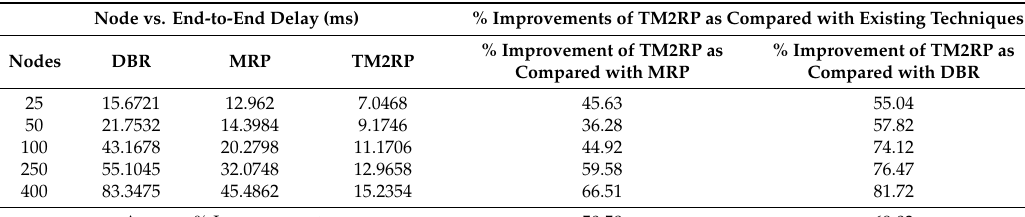
Table 5. The obtained results of TM2RP with regard to end-to-end delay.